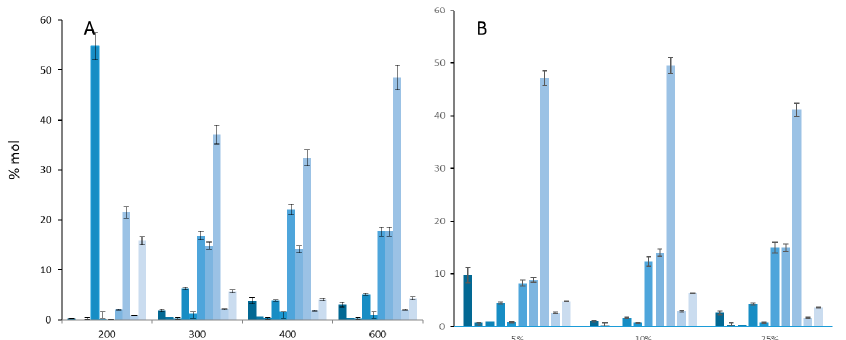
Figure 1. %mol (Ai/ ∑ Ai) of fatty acid methyl esters (C 9 to C 18 ) in function of ( A ) the temperature of thermochemolysis (with 25% TMAH in MeOH) and ( B ) the percentage of TMAH in methanol (at 600 °C, 15 μ L TMAH solution).